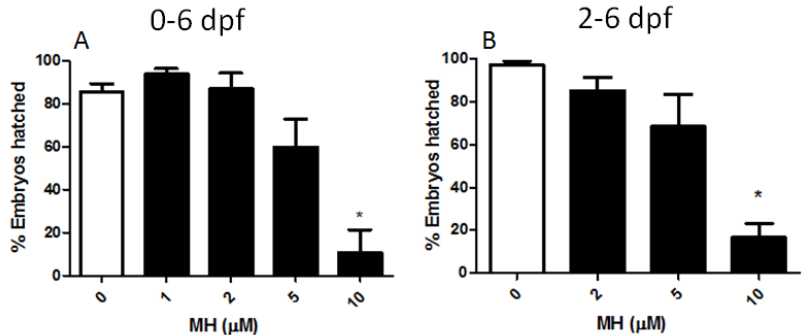
Figure 7. The effectiveness of MH at different concentrations at altering hatching of medaka embryos. Under pure culture conditions, embryo hatching efficacy was altered by increasing concentrations of MH. ( A ) Embryos were treated with increasing concentrations of MH for six days from hour 5 (0 – 6 dpf). MH concentrations of 5 μ M and higher were required to cause a delay in hatching. Hatchability of embryos from six days MH (10 μ M)-treatment was significantly decreased in comparison to untreated controls until 10 dpf. The external differences in appearance of the newly hatched control frys on day ten and the 10 μ M MH-treated embryos were significantly obvious. ( B ) Embryos were treated with increasing concentrations of MH for four days from stage 25 (2 – 6 dpf). MH concentrations of 10 μ M and higher were required to significantly cause a delay in hatching. Results are given as the mean percentage of hatching efficiency ± SEM ( n > 8 embryos for each condition). Statistical analysis was performed by one- way ANOVA followed by Tukey’s post -hoc multiple comparison test. p < 0.05 was considered as significant. The asterisk (*) indicates values significantly different from the control.